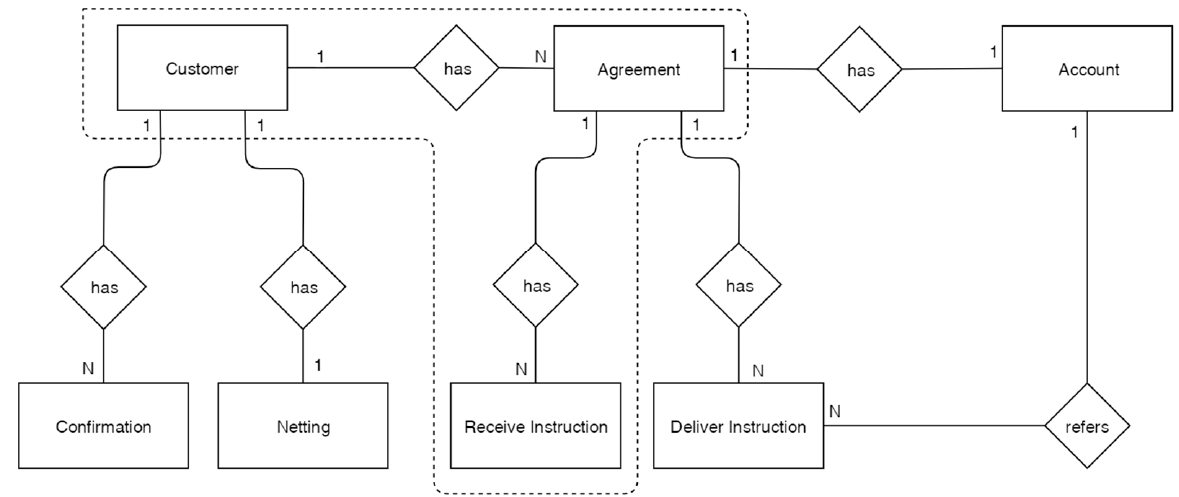
Figure 15. The consistency unit identified in the simplified conceptual database schema.